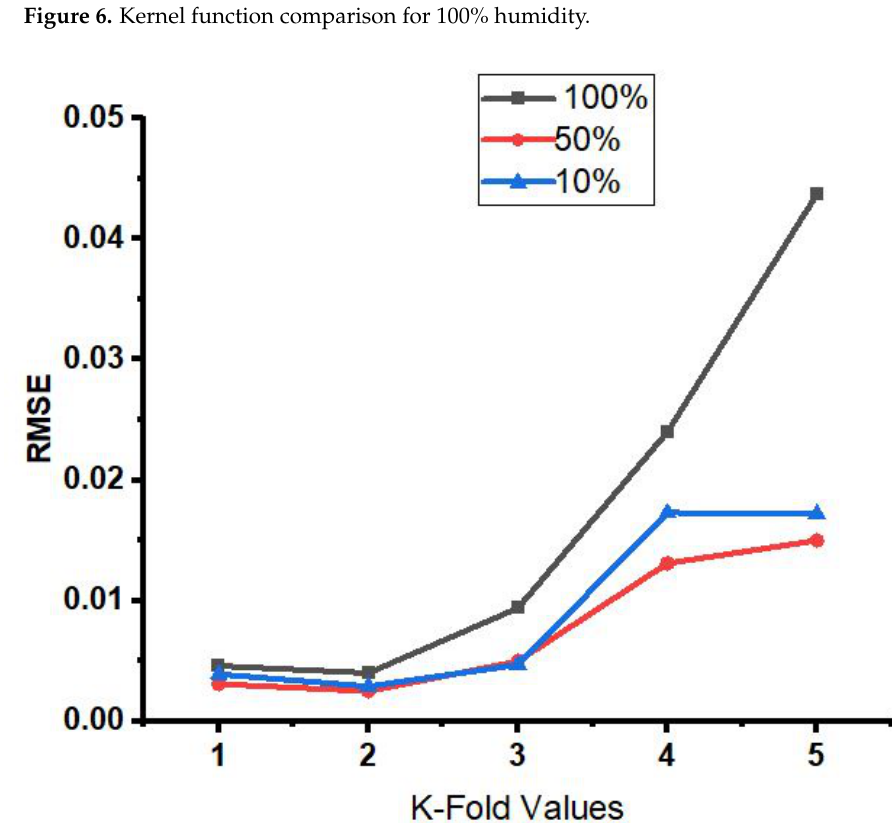
Figure 7. SVMR model with various humidity